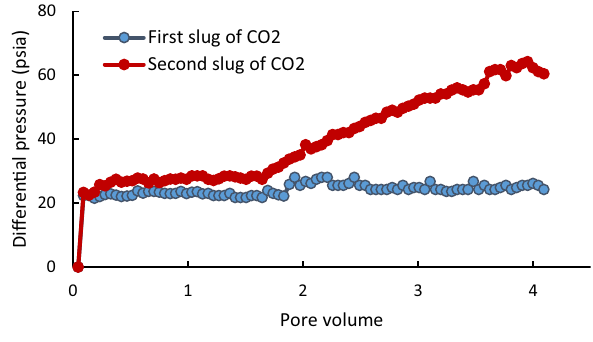
Fig. 4 Performance of injected CO